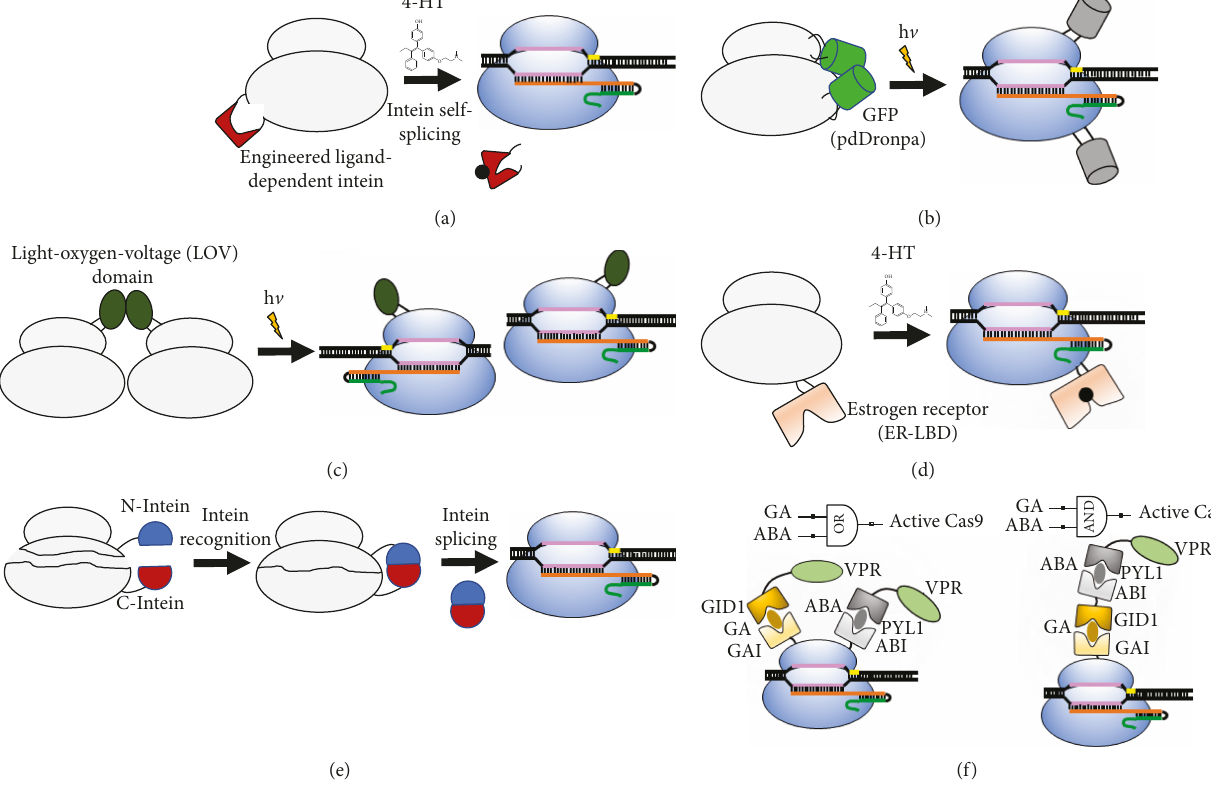
Figure 3: Selected case studies of engineering dCas9 by domain fusion. (a) Intein insertion inactivates dCas9, and in the presence of 4-HT, the inserted intein (red) undergoes self-splicing and restores the active Cas9 structure and function [70]. (b) Insertion of an engineered GFP (pdDronpa) that dimerizes in the dark and prevents DNA binding. On light illumination, pdDronpa dissociates and enables the binding of dCas9 to DNA [71]. (c) In the absence of light, the LOV domain (dark green) maintains a stable dimer that sterically blocks dCas9 function. Light induces LOV dissociation and Cas9 activation [74]. (d) Domain insertion of a ligand-binding domain (LBD) of the estrogen receptor ER leads to an allosteric activation by 4-HT [75]. Rather than domain insertion, an end-to-end fusion with ER-LBD results to nuclear translocation by 4-HT [58]. (e) A split Cas9 composed of two separate fragments is fused to intein sequences that perform self-splicing upon dimerization, leading to fully active Cas9 [83]. (f) The dCas9 fusion with multiple domains can generate a multi-input system and produce logic gates [57]. A VPR – SpdCas9 construct induces gene expression in the presence of gibberellin (GA) OR/AND abscisic acid (ABA). A light gray color of the Cas9 indicates that the protein is inactive or less active while blue represents the active